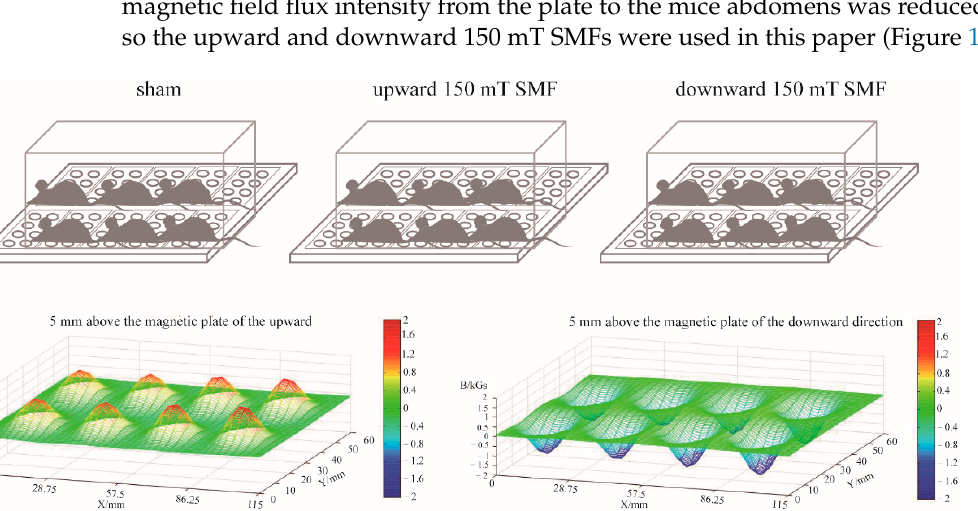
Figure 1. Magnetic field exposure system. ( A ) 150 mT magnetic plates were composed by 10 small magnetic blocks with the same magnetic pole (N or S). The cages were placed on the magnetic plate, and each cage contained 6 mice. ( B ) The magnetic flux intensity of 150 mT magnetic plates were about 150 mT at 5 mm above the plates.